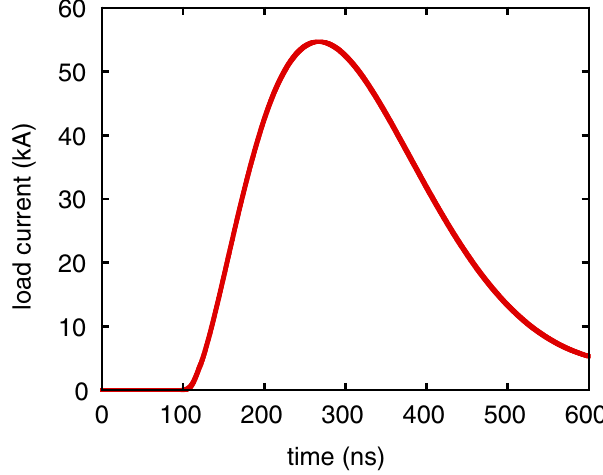
FIG. 7. Simulated load-current time history for a Neptune shot conducted with a single Marx generator. The peak current is 55 kA.